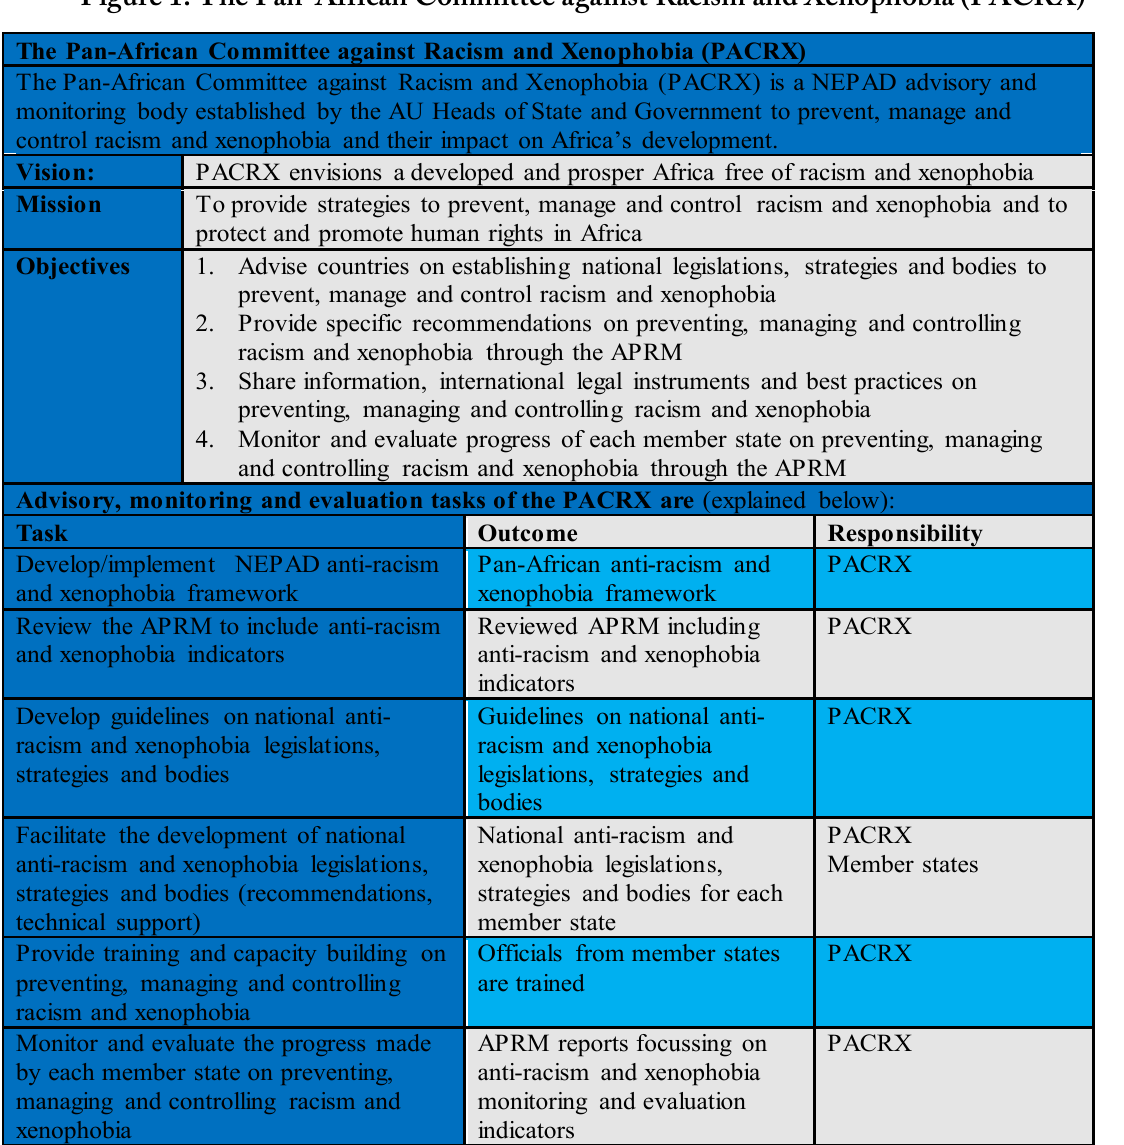
Figure 1: The Pan-African Committee against Racism and Xenophobia